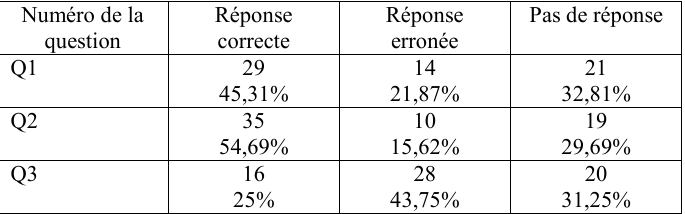
Tableau 2. Résultats de la partie 2 du